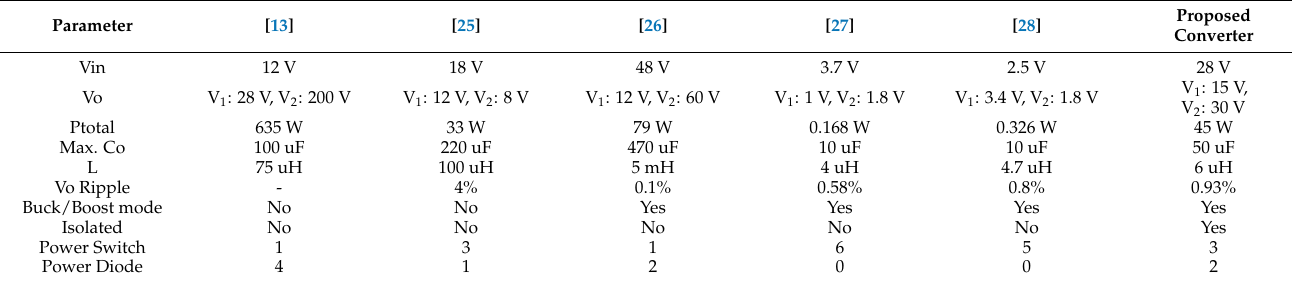
Table 2. Comparison among SIMO DC converters normalized for two output